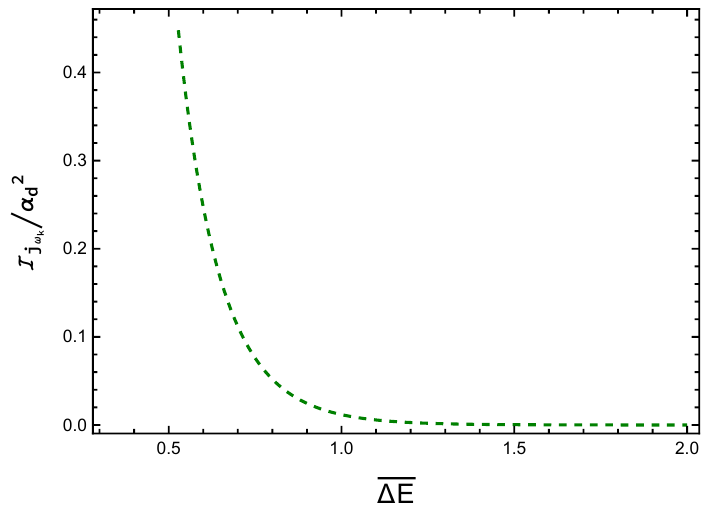
is plotted for two outgoing null detectors in a (1+1) dimensional /α 2 d ωk = 0 . 2 . This nature will be the same for all d/α k